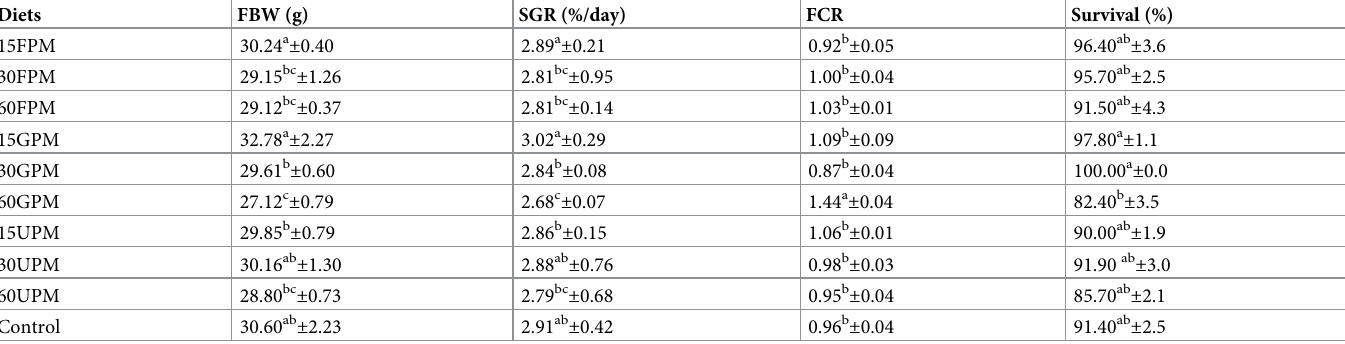
Table 3. Final Body Weight (FBG), Specific Growth Rate (SGR), Feed Conversion Ratio (FCR) and survival of juvenile barramundi fed untreated, fermented and germinated peanut meals at various inclusion levels.